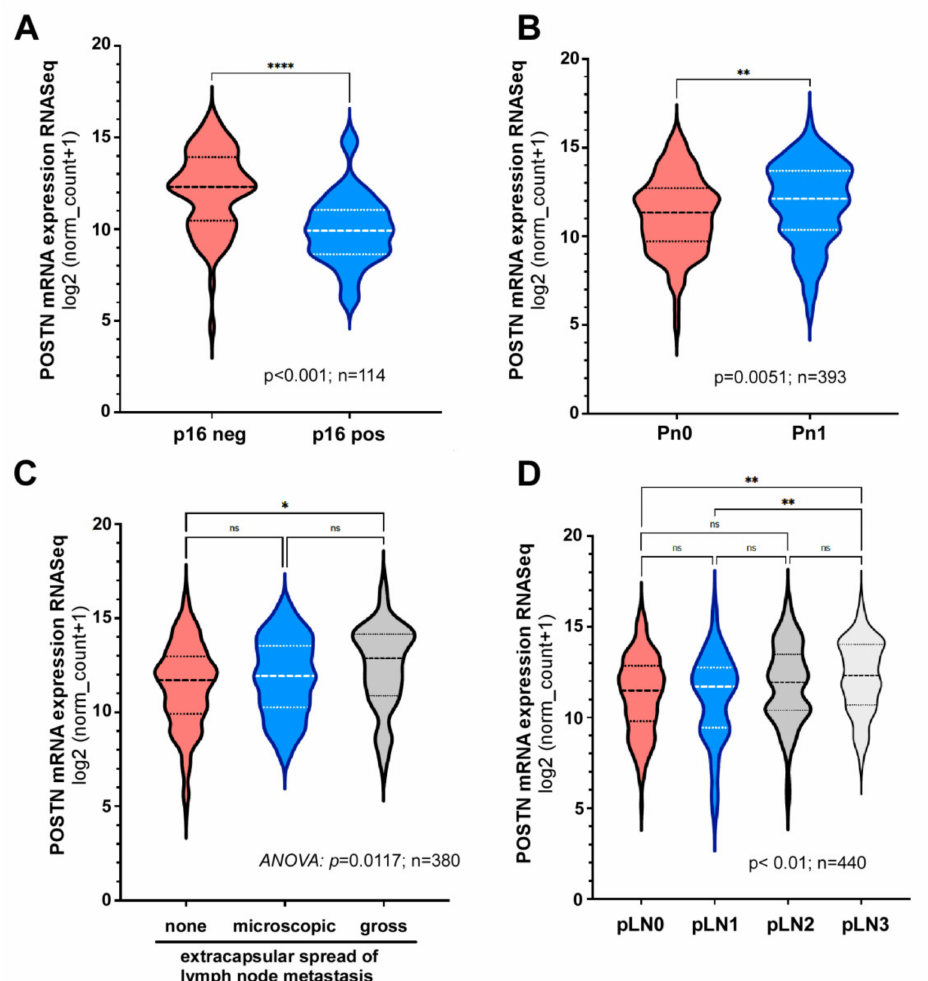
Figure 2. OSF-2 expression correlates with HPV status and markers of metastatic disease. Bioin- formatic analysis of the TCGA HNC patient cohort ( n = 612). High OSF-2 expression significantly correlates with ( A ) HPV status, ( B ) perineural infiltration, ( C ) extracapsular spread (ECE), and ( D ) pathological lymph node status (pLNx) for p16 negative or unknown. N2a/b/c and N3a/b are pooled, respectively; AJCC 8th Edition. p -values and sample size ( n ) as indicated. * p < 0.05, ** p < 0.01, **** p < 0.0001, and ns indicates not